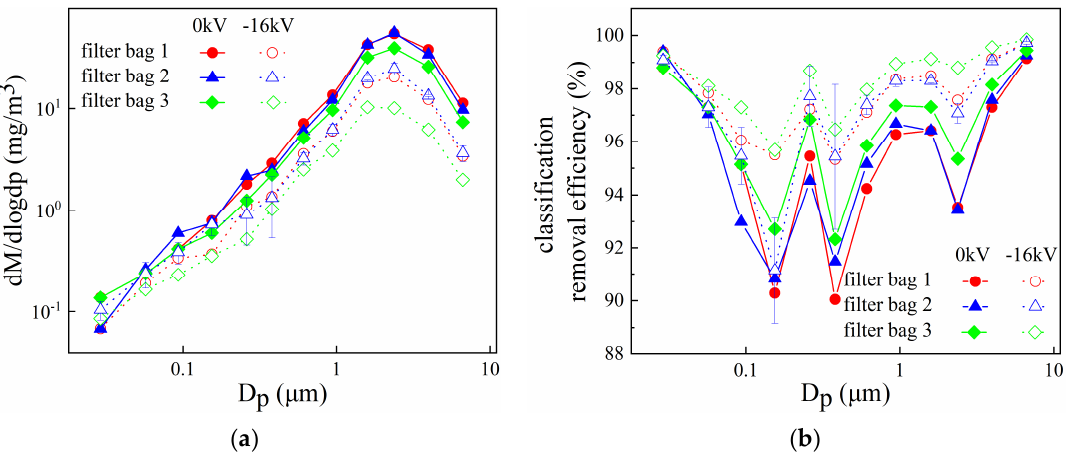
Figure 4. Classified dust removal performance of the dust collectors: ( a ) classified particle mass concentration; ( b ) classification removal efficiency.